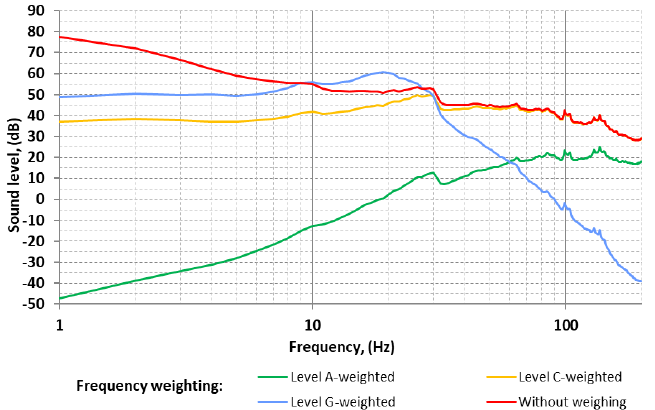
Figure 5. Courses of noise spectra generated by T2 turbine by application of various weighting curves.